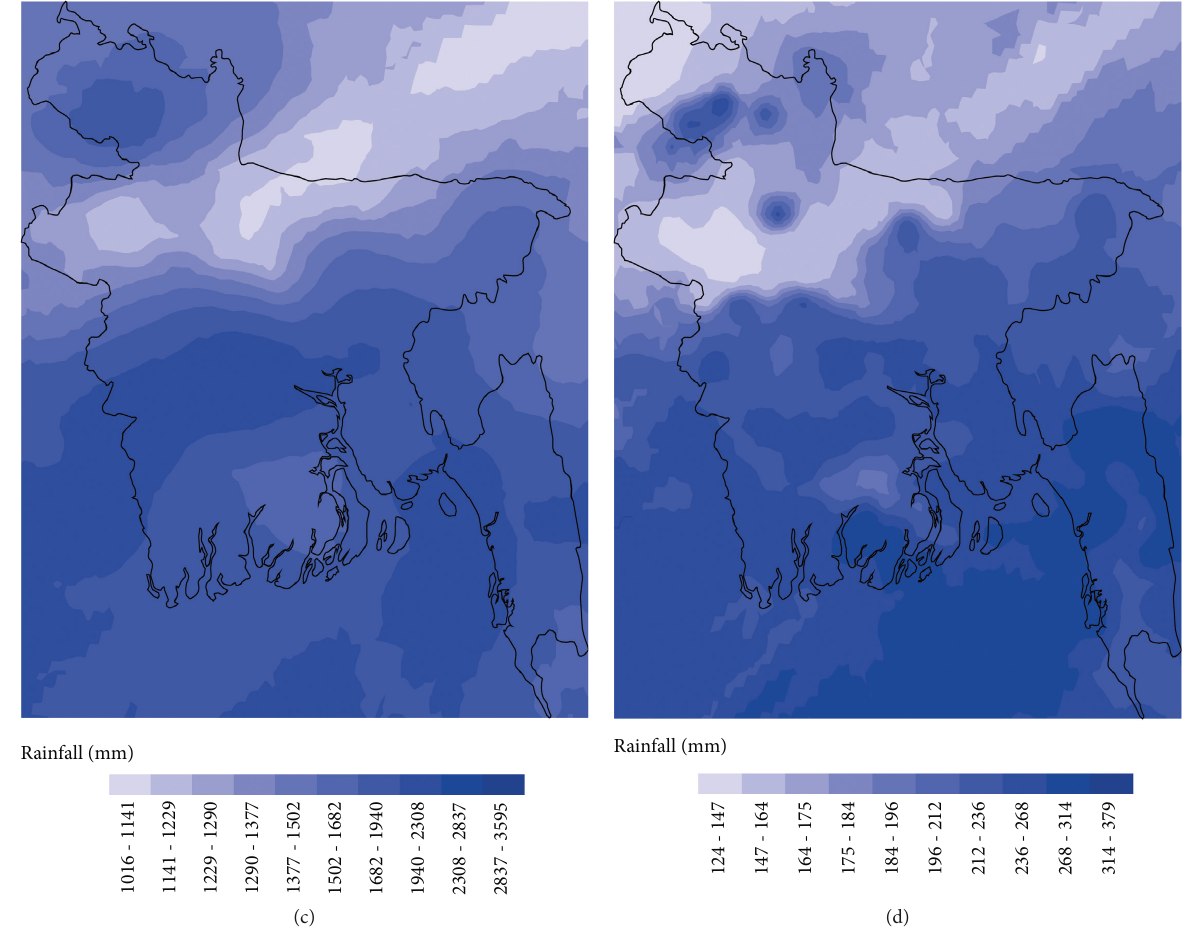
Figure 6: Mean seasonal precipitation distribution of (a) winter, (b) premonsoon, (c) monsoon, and (d) postmonsoon in Bangladesh during 1989–2018.